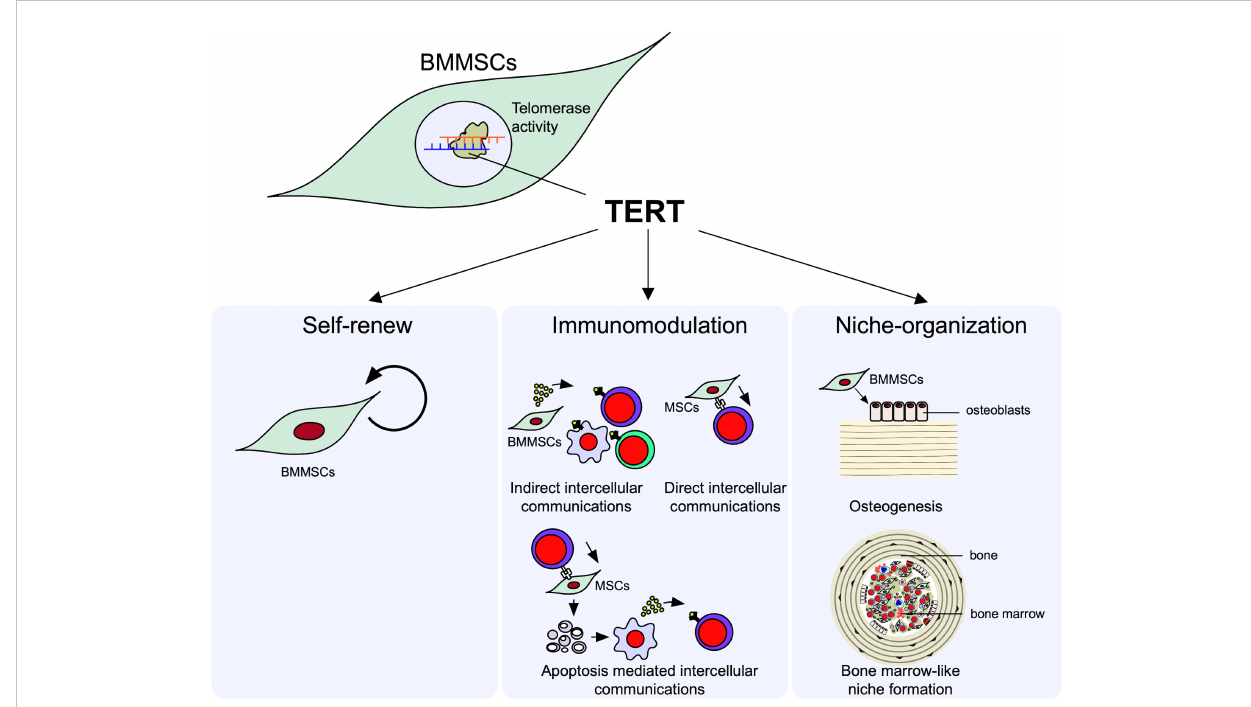
FIGURE 1 Microenvironmental modulation of bone marrow mesenchymal stem cells (BMMSCs). Telomerase reverse transcriptase (TERT) mediated telomerase activity in BMMSCs regulates their self-renew and microenvironmental modulation, including immunomodulatory and niche organizing functions. BMMSCs exhibit the self-renewal capacity to maintain their stemness. BMMSCs exhibit immunomodulatory function; BMMSCs can suppress the differentiation of interleukin 17-producing helper T (Th17) cells and induce the differentiation of regulatory T cells (Tregs) in directly (cell-cell- contact) and indirectly (paracrine factors and extracellular vesicles [EVs]) manners. BMMSCs can differentiate into osteoblasts and form de novo lamellar bone matrix. BMMSCs can conduct recipient derived bone marrow cell-like hematopoietic cells and organize hematopoietic niche surrounded by bone